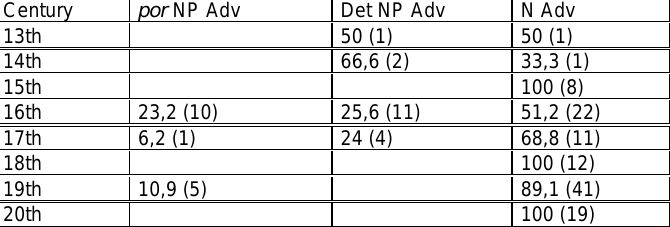
Table 2. Frequency of cuesta arriba/asuso ‘uphill’